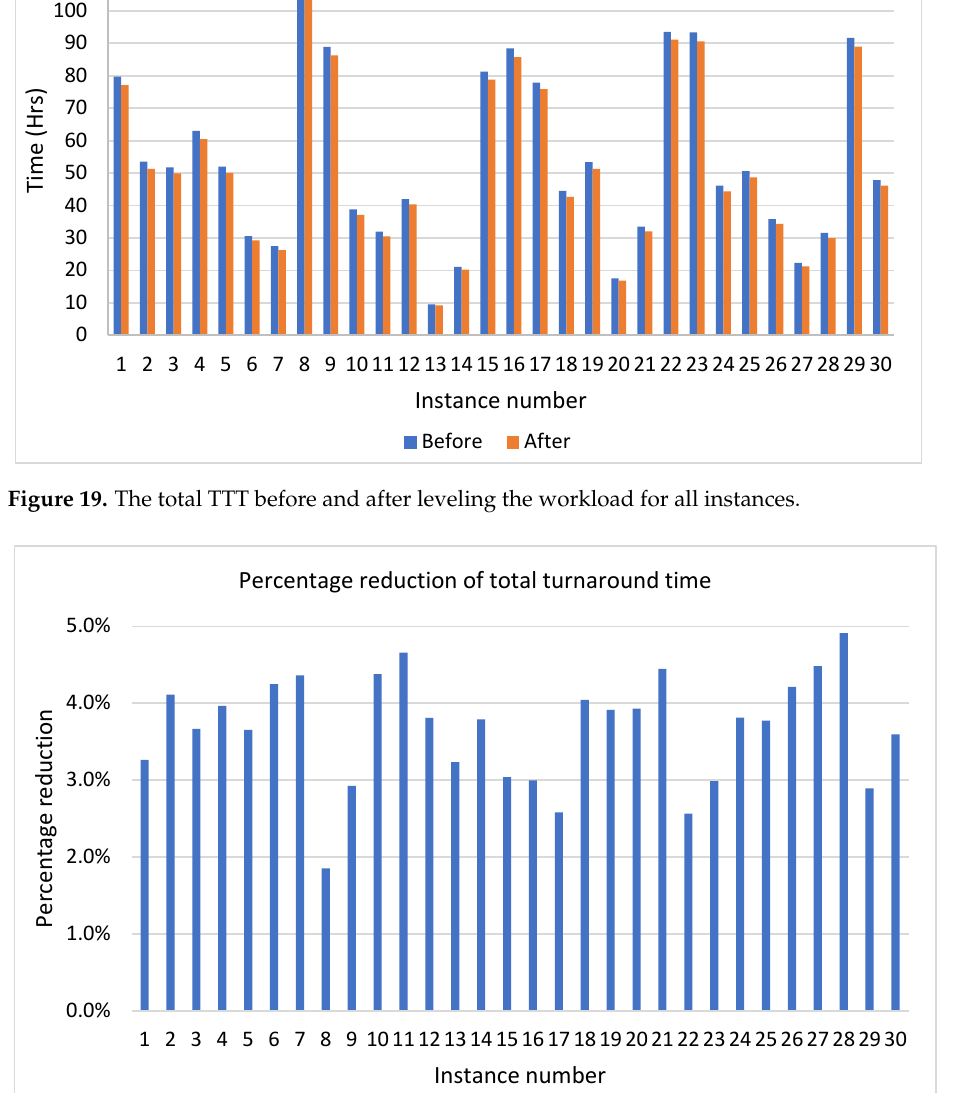
Figure 20. The percentage of reduction in total TTT.